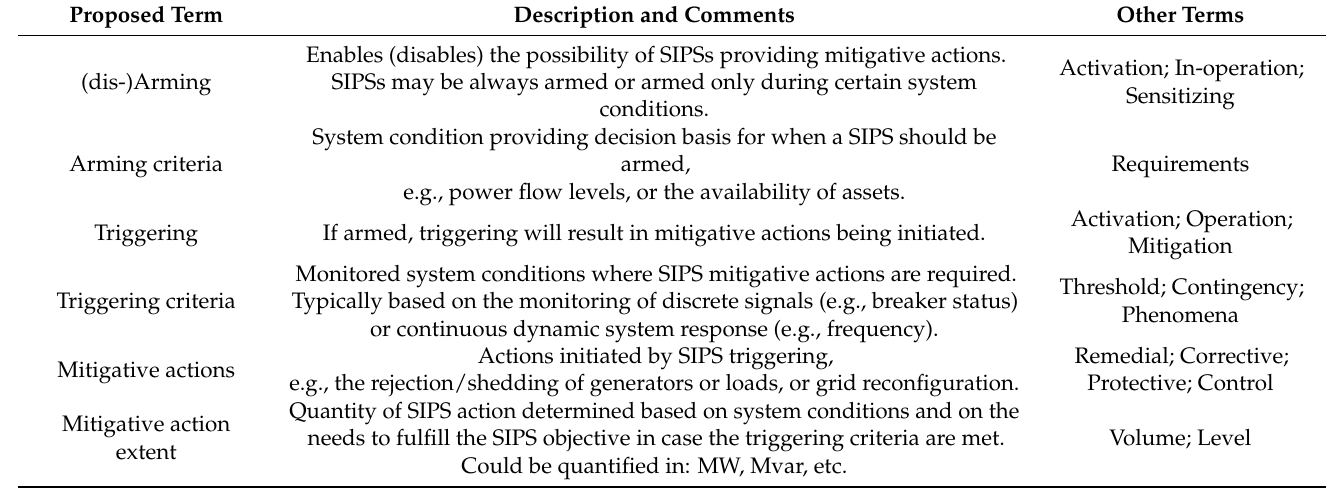
Table 1. List of terms related to the design of System Integrity Protection